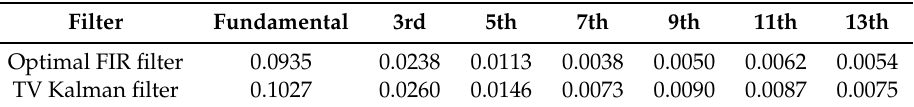
Table 4. The rms estimation